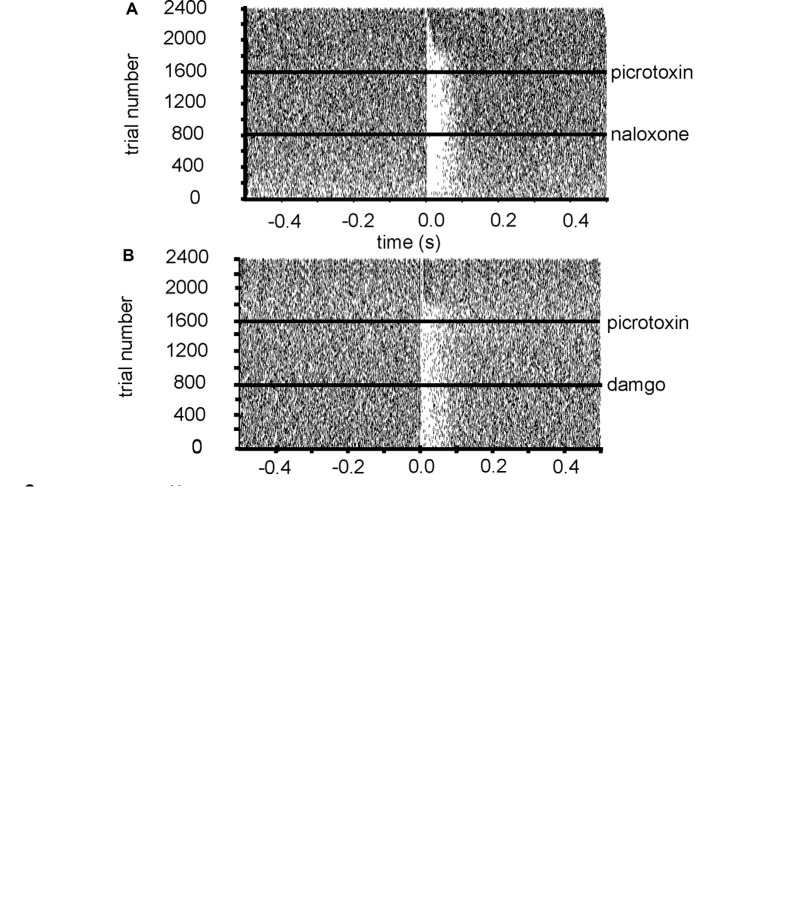
Inhibition of VP neurons by NAc stimulation is not affected by opioid agonists. All experiments presented in this figure used the first stimulation protocol (one stimulation of 200 μs duration followed by a 10-s gap) identified in the “Materials and Methods” section. (A) A typical example of a raster plot of tonic firing activity in a VP neuron (from −0.5 s to 0.5 s post-stimulation of the NAc). The raster plot shows a neuron’s response during 800 applications of stimulation in control conditions, 800 stimulations after the application of naloxone, and 800 stimulations after the application of picrotoxin. (B) A typical example raster plot of tonic firing activity in a VP neuron 0.5 s pre-stimulation and 0.5 s post-stimulation of the NAc. The raster plot exemplifies one neuron’s response during 800 applications of stimulation in control conditions, 800 stimulations after the application of DAMGO, and 800 stimulations after the application of picrotoxin. (C) Bar chart representing significant differences (**P < 0.01) in pause duration for neurons in control conditions, the presence of naloxone and the presence of picrotoxin. (D) Bar chart representing significant differences (*P < 0.01 and *P < 0.05) in pause duration for neurons in control conditions, the presence of DAMGO, and the presence of picrotoxin. (E) Bar chart representing non-significant (P > 0.05) differences in the average firing frequencies for neurons in control conditions, in the presence of naloxone and in the presence of picrotoxin. (F) Bar chart representing non-significant (P > 0.05) differences in the coefficient of variation for neurons in control conditions, in the presence of naloxone and in the presence of picrotoxin. (G) Bar chart representing non-significant (P > 0.05) differences in the average firing frequencies for neurons in control conditions, in the presence of DAMGO and in the presence of picrotoxin. (H) Bar chart representing non-significant (P > 0.05) differences in the coefficient of variation for neurons in control conditions, in the presence of DAMGO, and in the presence of picrotoxin.